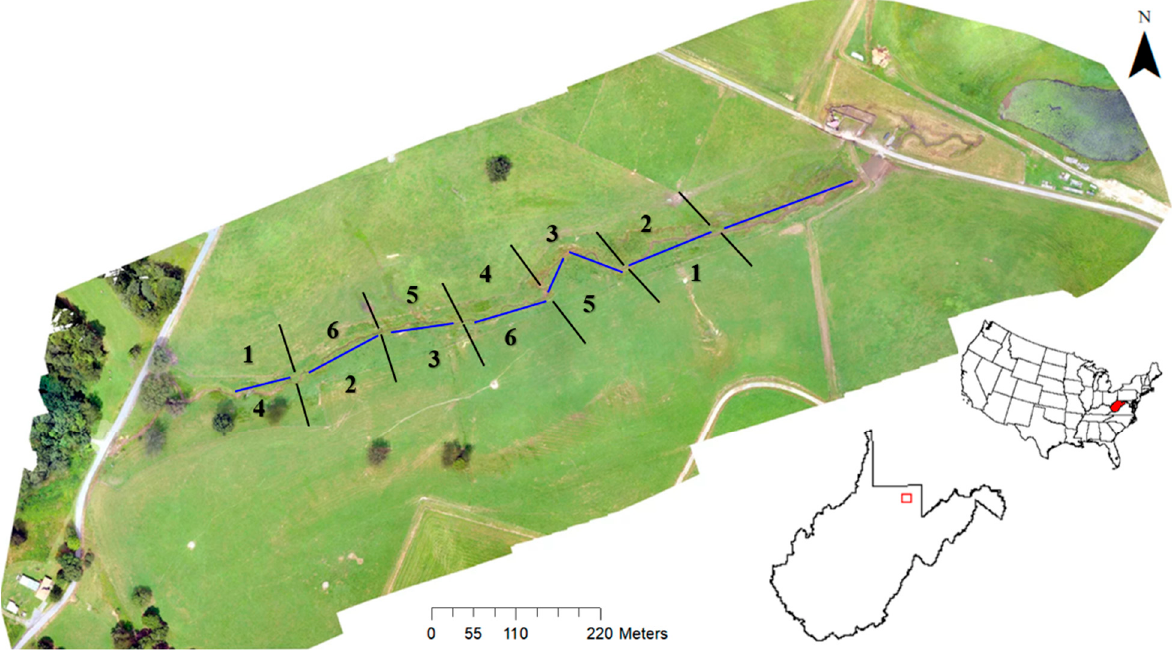
Figure 1. Proposed cover treatment sites along Ruby Run at the JW Ruby Research Farm, Reedsville, West Virginia, USA. Drone imagery was provided by Paul Kinder, West Virginia University Natural Resources Analysis Center. Proposed cover treatments were taken into consideration when surveying birds, anurans, and small mammals and are as follows: (1) control, which is defined as only straw mulch being applied; (2) wood mulch; (3) riparian herbaceous species; (4) riparian woody species; (5) bioenergy species (i.e., switchgrass ( Panicum virgatum )); and (6) wet meadow herbaceous species.